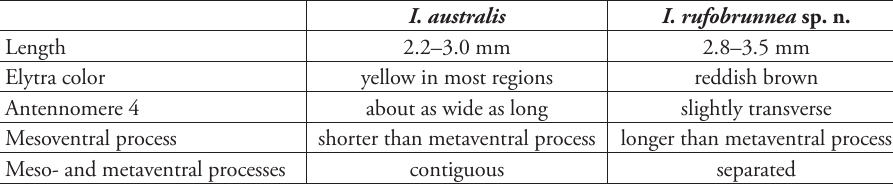
Table 1. Differences between I . australis Cameron and I . rufobrunnea sp. n.